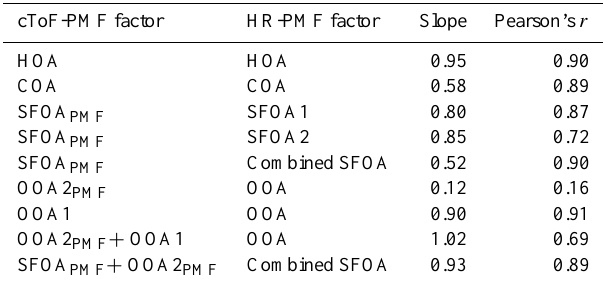
Table 2. Time series comparison of the PMF factors from the cToF- AMS and HR-ToF-AMS for the winter